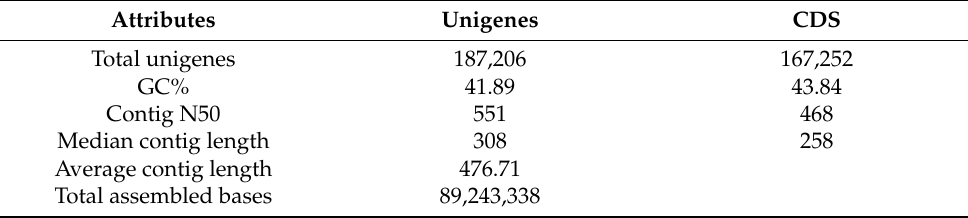
Figure 1. Length distribution of de novo assembled unigenes and coding sequences (CDS). Table 1. Statistics of complete transcriptome assembly.